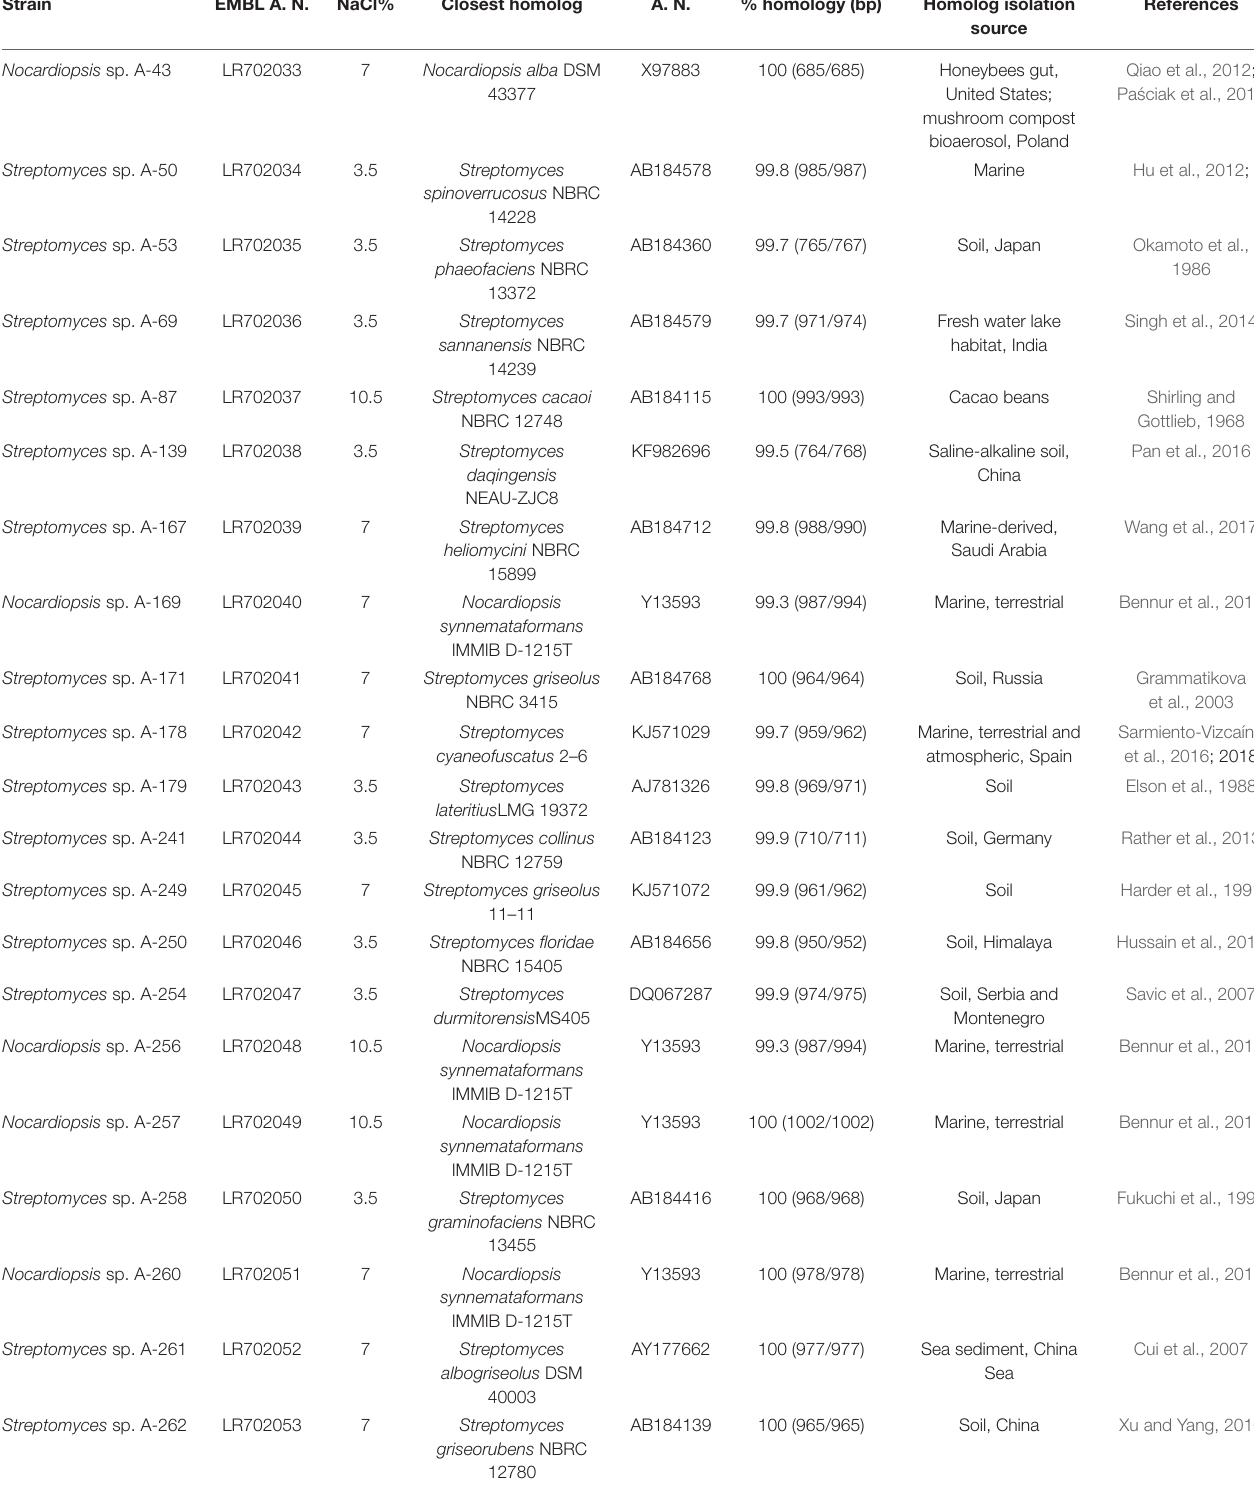
TABLE 2 | Phylogenetic diversity of atmospheric-derived bioactive Actinobacteria isolates.